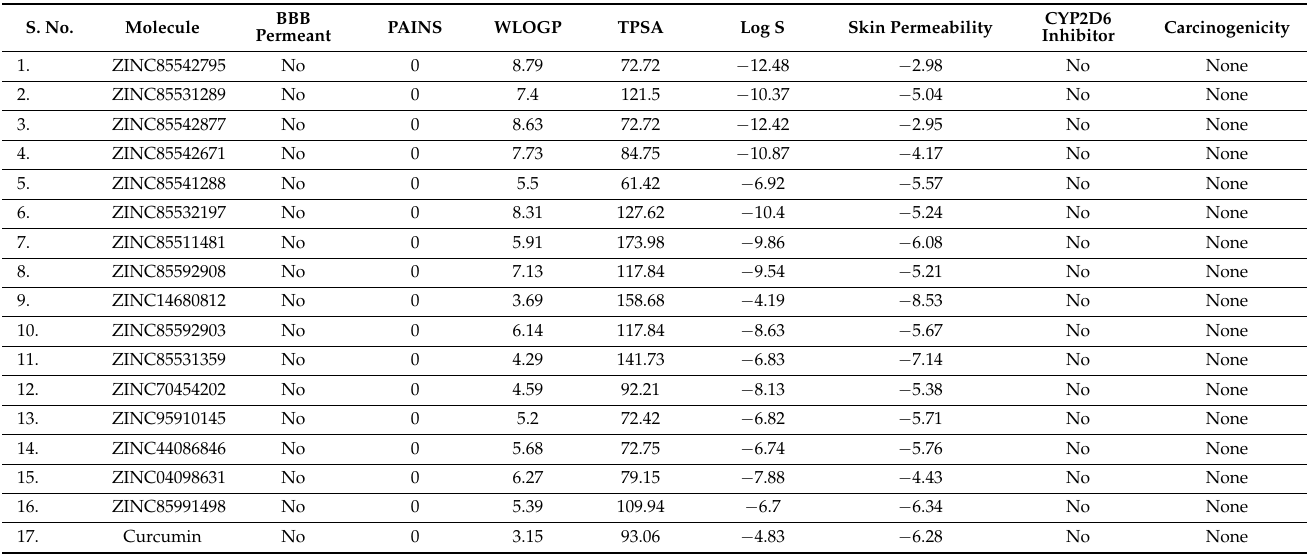
Table 2. ADMET properties of the selected compounds for MSTN